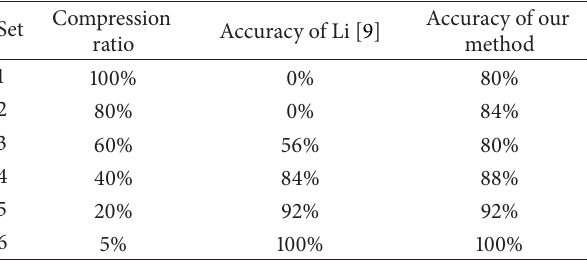
Table 3: Comparison between two